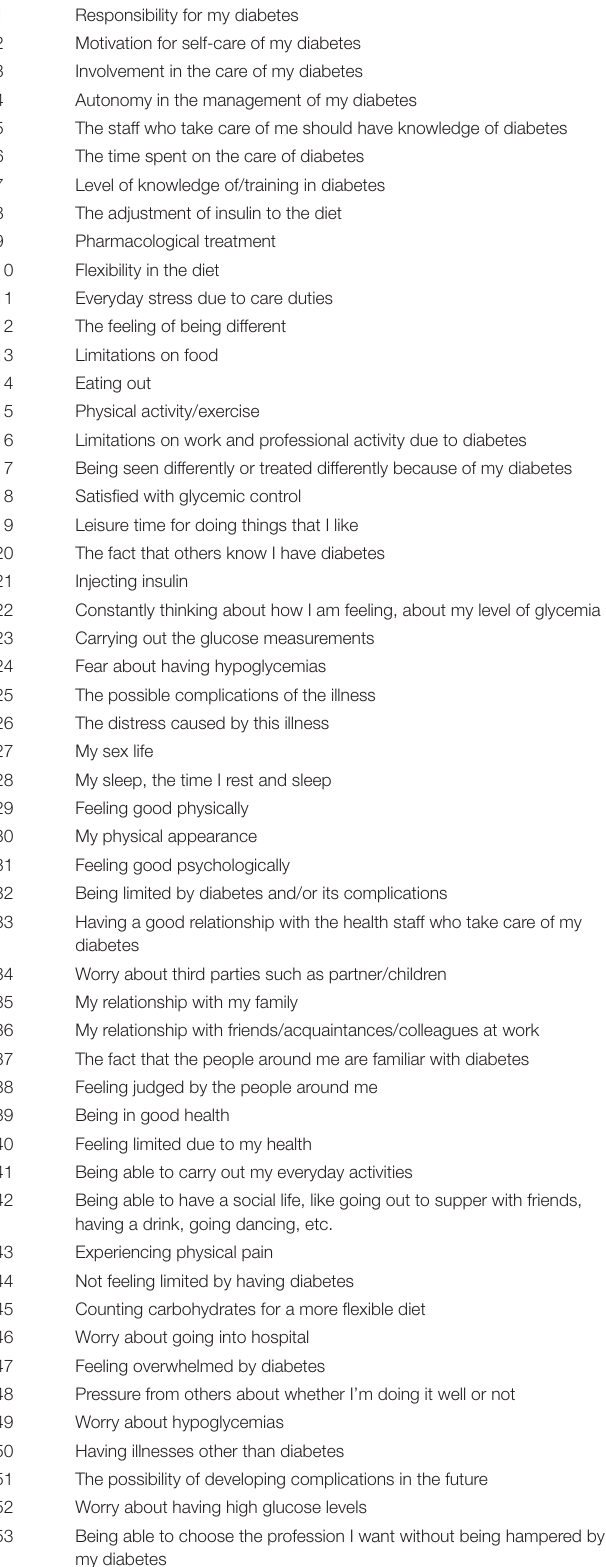
TABLE 1 | Issues on the Health-Related Quality of Life